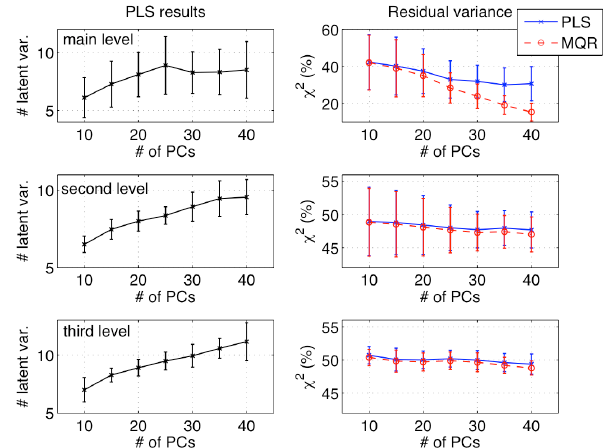
Figure 10. PLS cross-validation results for the three-level empirical model with quadratic nonlinearity in the main level. The error bar plots show the mean and standard deviations of each quantity displayed computed using individual values of this quantity for each of the model equations (the number of equations is equal to the number of original PCs simulated by the empirical model). Left panels: the optimal number of PLS components; right panels: the percentage of variance unaccounted for by the regression; x -symbols show the results of PLS regression using the optimal number of latent variables, while the circles display the results of standard MQR, with all predictors considered.